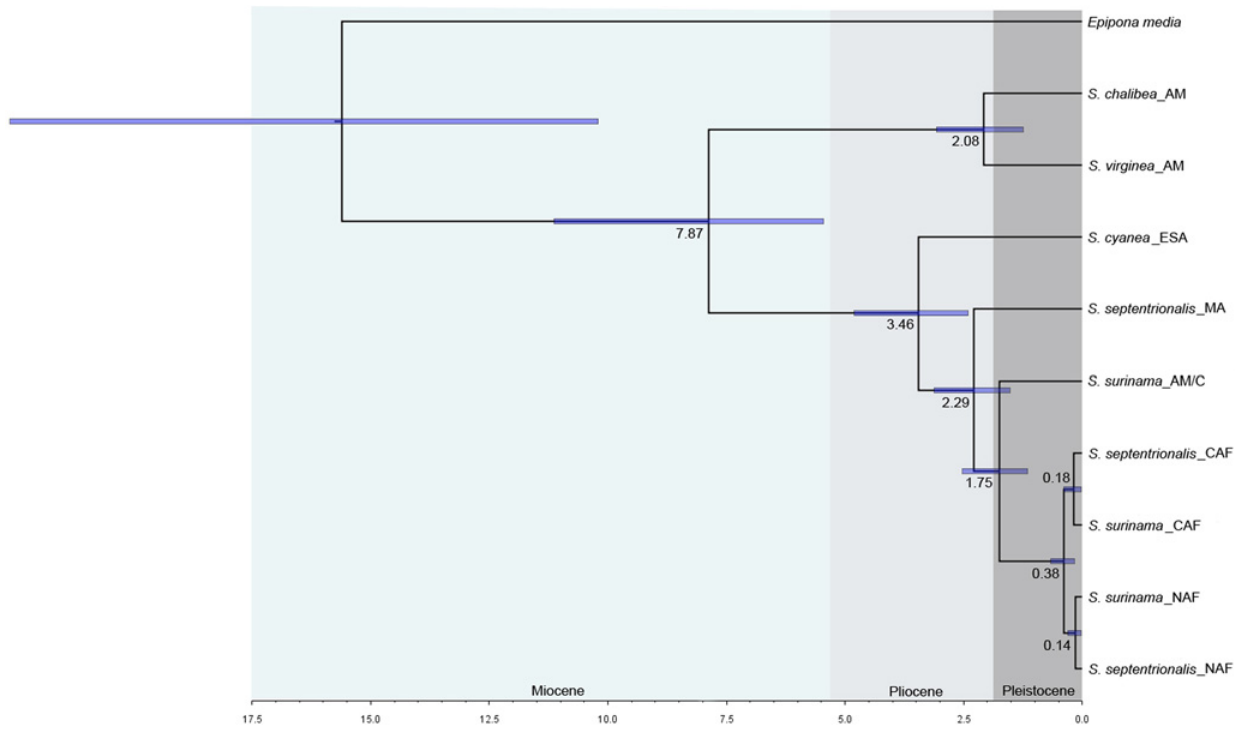
Fig 5. Chronogram with divergence times generated by BEAST. Divergence times between clades are annotated on each node and standard deviations [95% of high posterior density (HPD)] are represented by the blue bars.